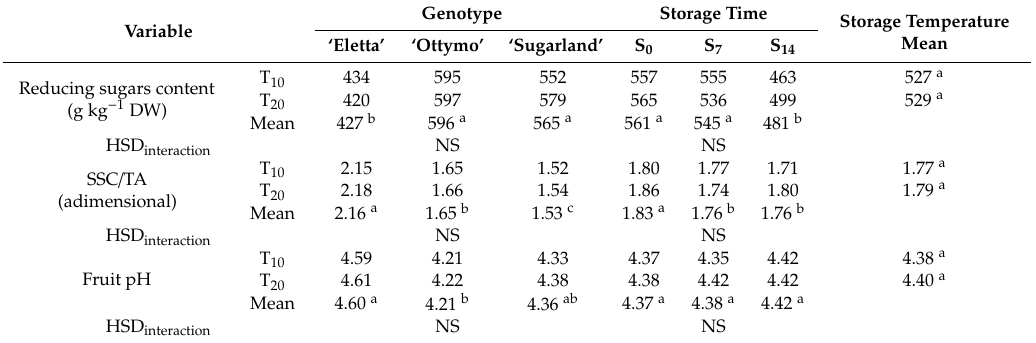
Table 4. Compositional variables related to fruit taste of cherry tomato as a ff ected by the main factors. Genotype Storage Time Variable